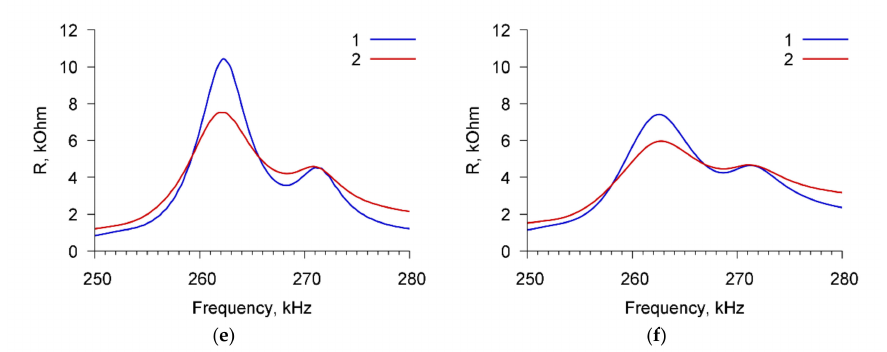
Figure 11. The frequency dependencies of the real part of the electrical impedance of a PZT resonator with a container loaded with A. brasilense Sp7 suspension before (curve 1) and after (curve 2) adding the specific Abs. The cell concentration was 10 3 cells / mL, the concentration of antibodies was 6 µ g / mL. The bu ff er conductivity was 10 µ S / cm ( a , c , e ) and 50 µ S / cm ( b , d , f ). The resonance peaks correspond to frequencies: 68.7 kHz ( a , b ), 97.8 kHz ( c , d ), and 264 kHz ( e , f ).